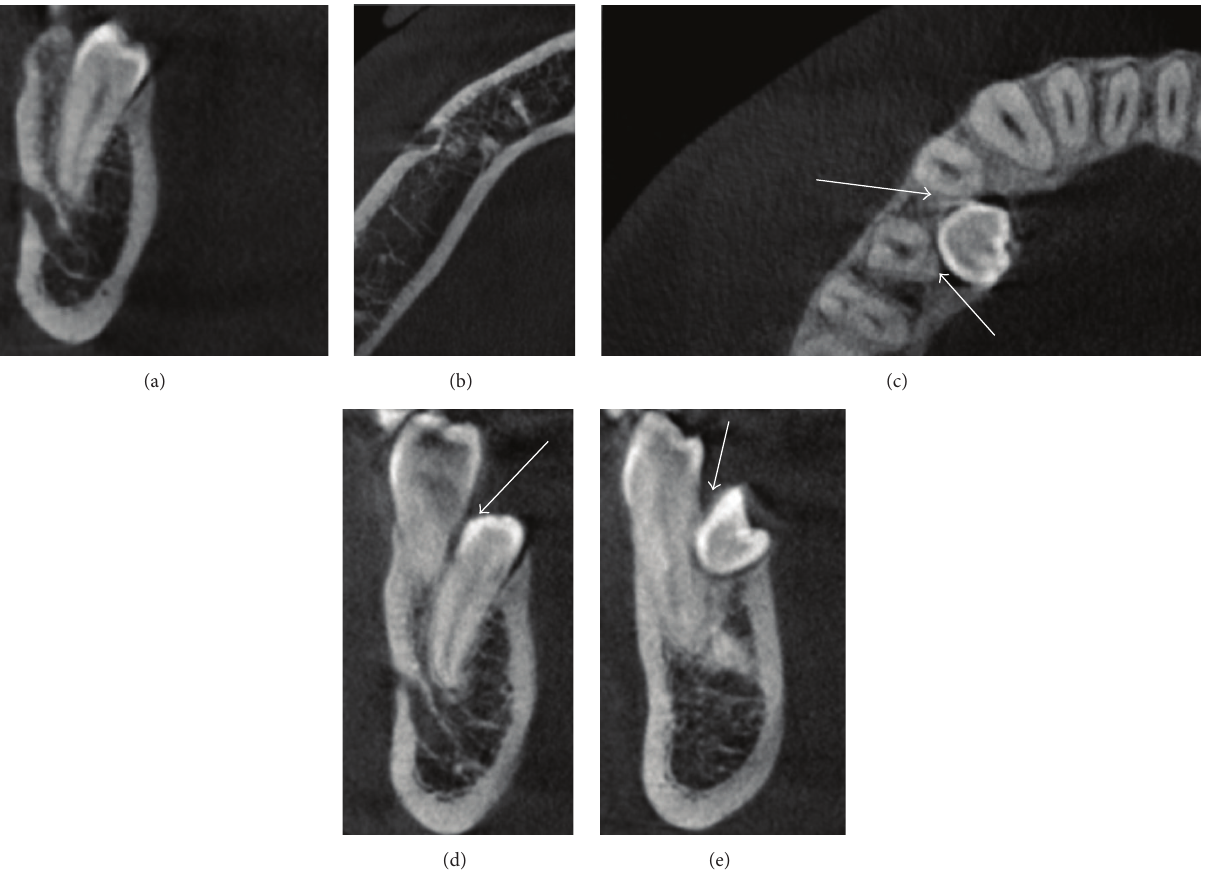
Figure 5: Case 3 CBCT: no continuity between the ST’s root and the alveolar nerve (a, b) and root resorption of contiguous teeth, indicated by the white arrows